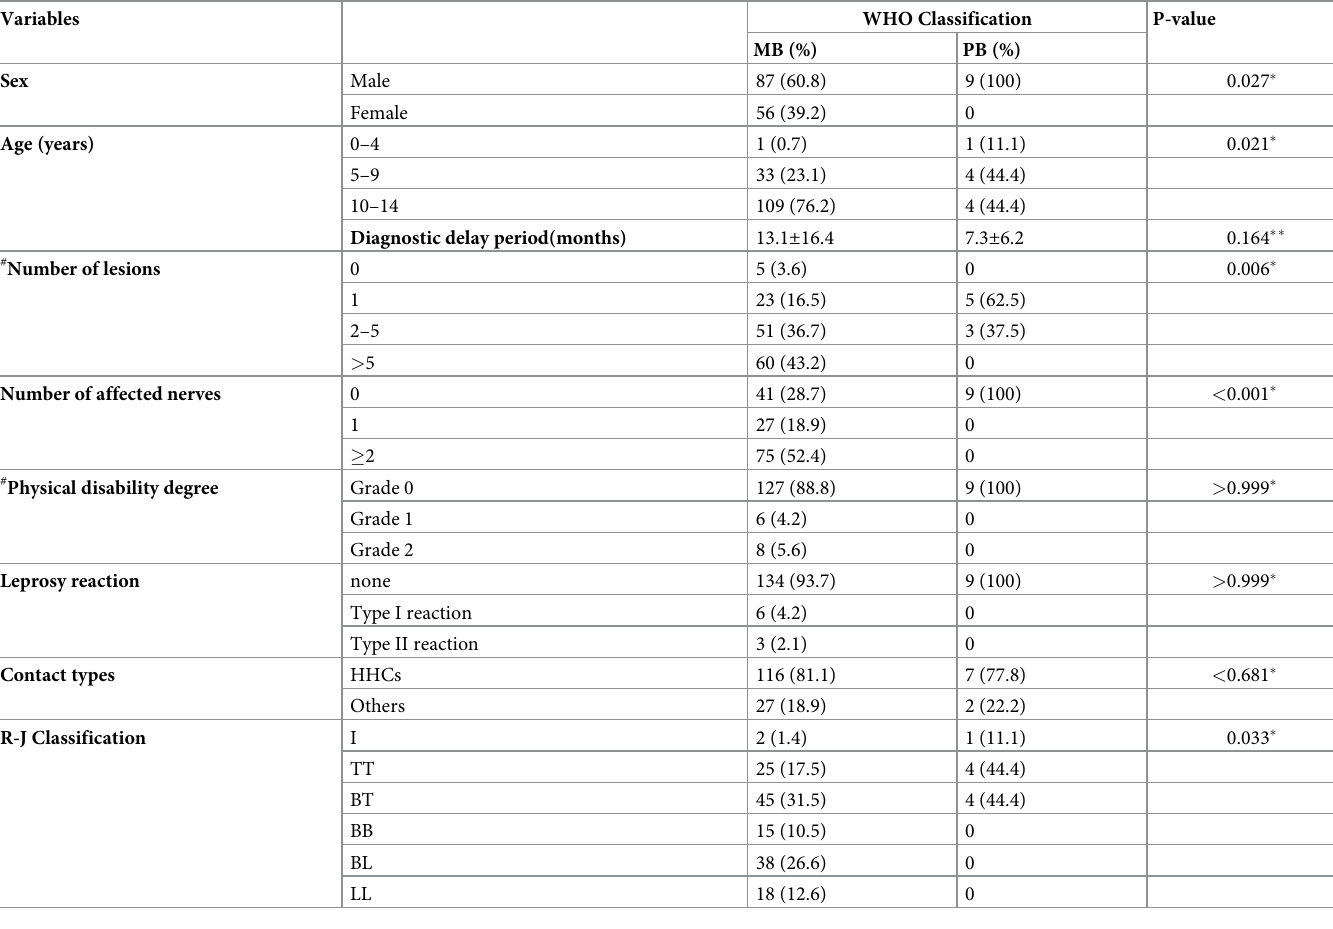
Table 2. Clinical and epidemiological characteristics of pediatric new cases according to WHO classification in China,